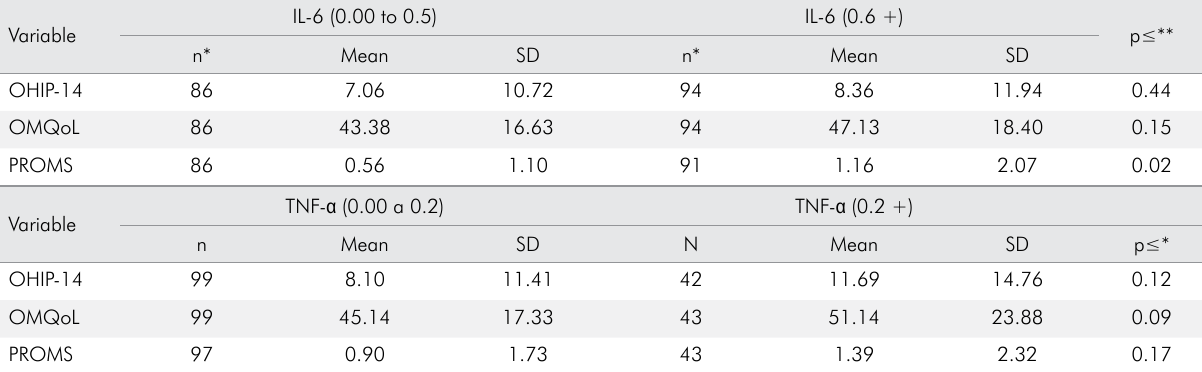
Table 5. Correlations between interleukin-6 (IL-6) (pg/mg protein) and tumour necrosis factor alpha (TNF- α ) (pg/mg protein) and quality of life indicators.